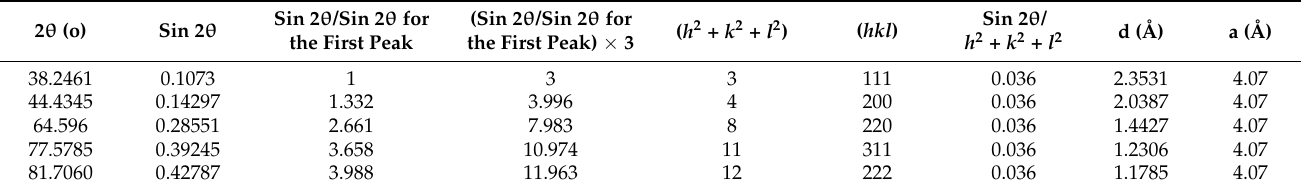
Figure 10. XRD diffractograms for different samples, (a) for sample 16 at different periods, (b) for samples 15, 17 and 18 which clearly show the formation of calcium with silver in the solution, (c) for sample 20 which clearly show the formation of silver oxide. Table 2. Calculation of Miller indices and lattice constant for sample 16 from diffraction angles.